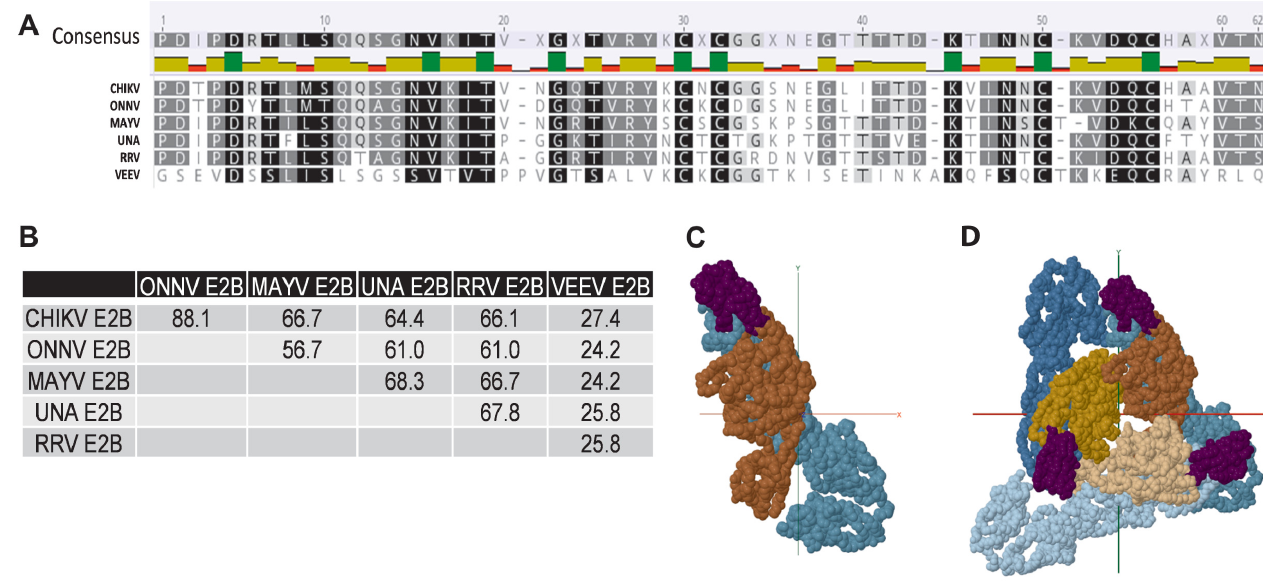
Fig 3. Comparison of Alphavirus E2 B domains. (A) Amino acid sequence alignment was performed using Geneious software for the E2 B domains of the alphaviruses examined in this study. Regions of 100% homology are highlighted in black, 80–100% similarity is dark grey, 60–80% similarity is light grey, and less than 60% similarity is in white. (B) Matrix depicts the amino acid sequence identity as a percentage. (C) Top-down view of the organization of the Mayaro Virus E1:E2 monomer (Teal:Brown) shown with the E2 B domain annotated in purple. (D) E1:E2 trimer spike organization depicted with the E2 B domain annotated in purple, E1 in shades of teal, and E2 in shades of